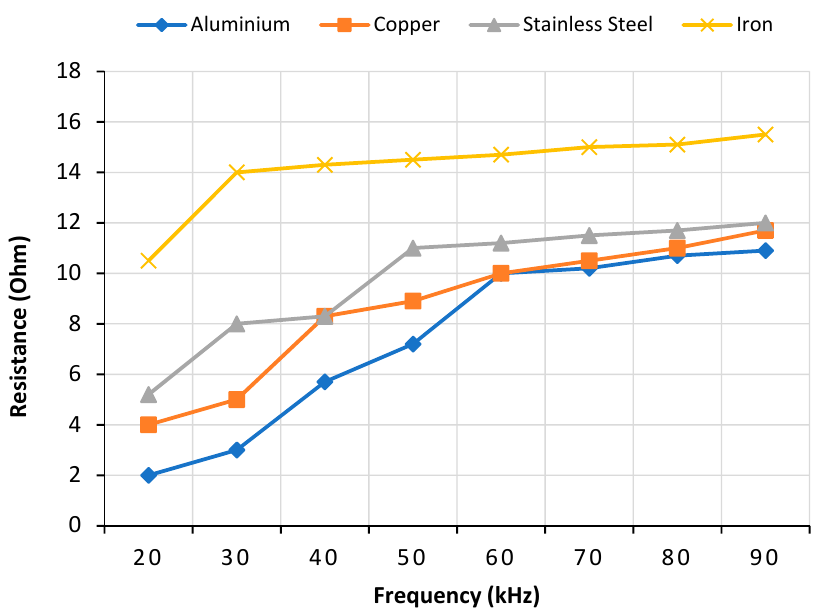
Figure 2. Frequency vs. resistance of different ferromagnetic and non-ferromagnetic materials (data taken from [31,32]).